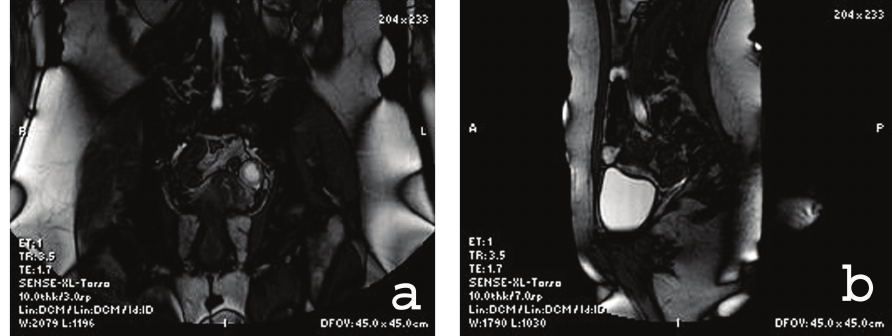
Figure 3: Uro-MRI: (a) and (b) ureteral hyperintense solid bulk below the bifurcation of the left common iliac artery.